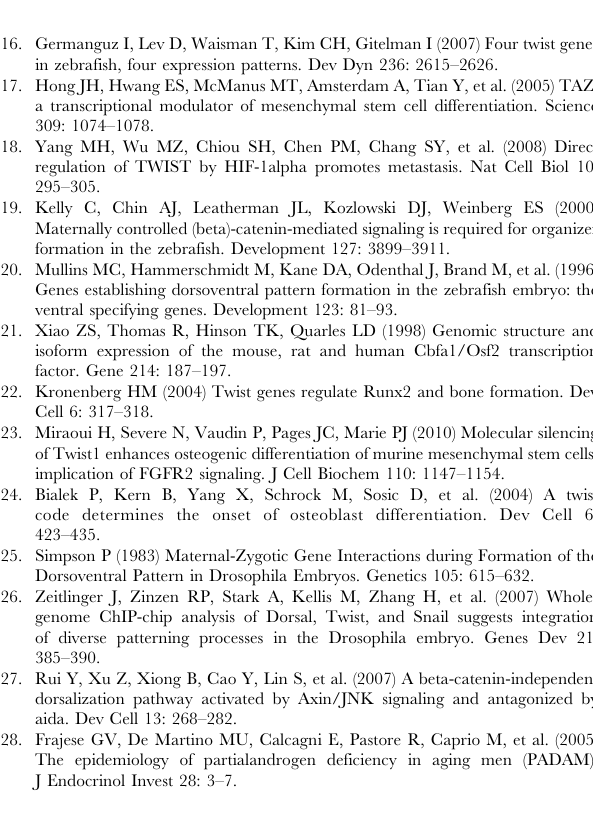
with indicated concentration of each atgMO. B, Zebrafish were microinjected with twist2 or twist3 atgMO and quantitative RT- PCR for T1 runx2b and T2 runx2b were performed at 48 hpf the appearance of dorsalized embryos and decreases the expression of runx2b. C, The table summarizing the dorsalized embryo features (D1-5/no defect) of zebrafish injected with each mRNA.